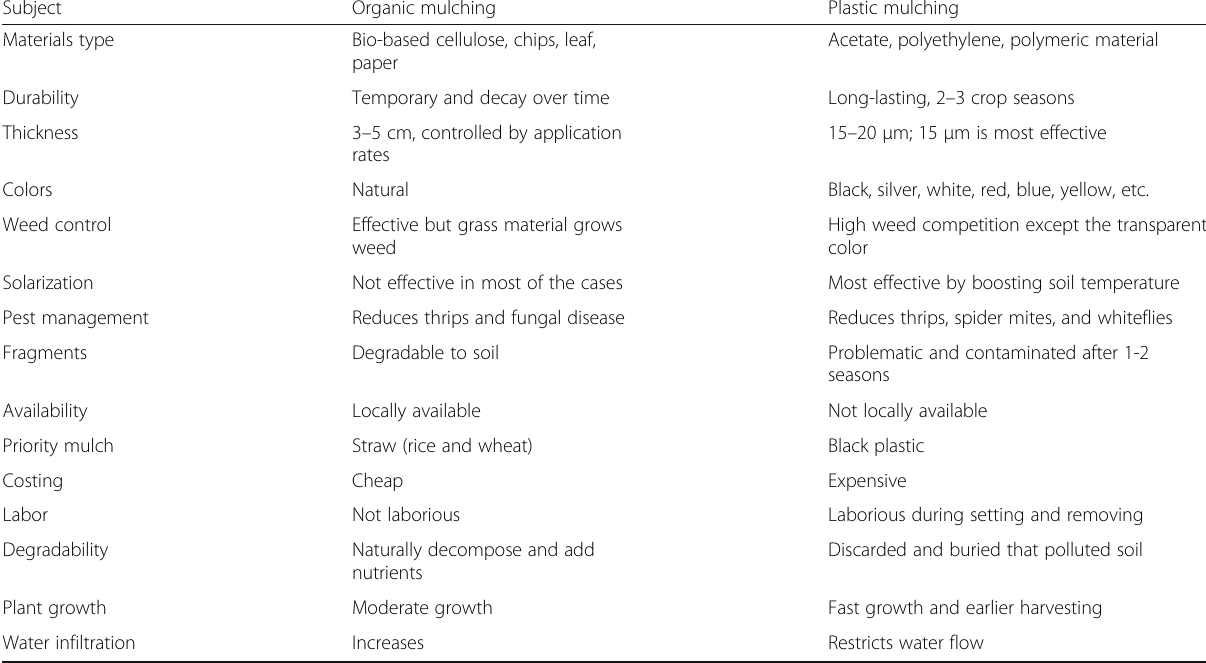
Table 1 Comparison of various characteristics between organic and plastic